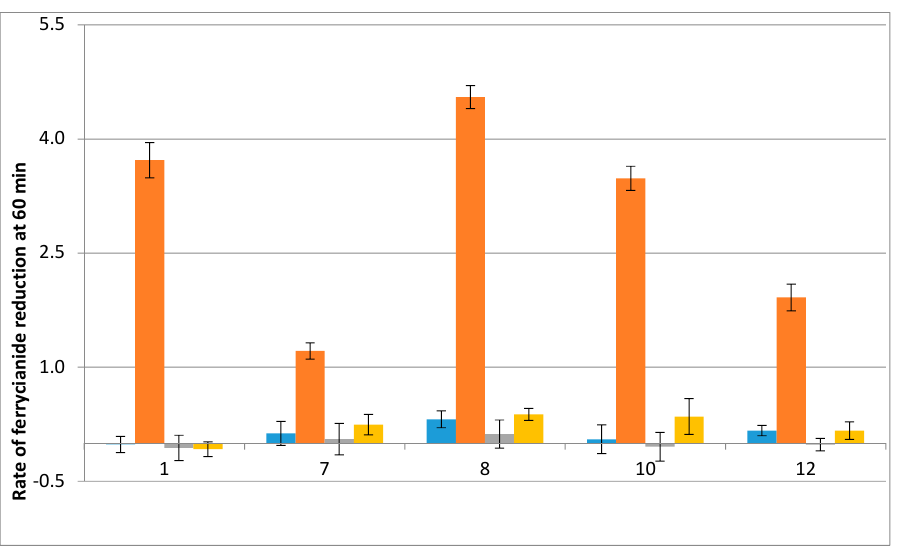
Figure 6. Rates of ferricyanide reduction reflect the metabolization of indolone derivatives in CHO cells. Ferricyanide reduction rates were measured (mean % reduction ± SD) in two cell lines treated for 60 min with potassium ferricyanide (600 µM), BNAH (100 µM), and the indicated indolone substrates (100 µM). One cell line overexpressed hQR2 (CHO-QR2, orange bars) and the other was not transfected (CHO-NT, blue bars), and therefore, expressed only endogenous QR2 levels. The % reduction was evaluated by comparing absorbance in treated cells to the absorbance measured in the absence of substrates. Cells were pre-incubated for 24 h with the QR2 inhibitor S29434 (20 µM): CHO-QR2 + S29434, yellow bars; CHO-NT + S29434, grey bars.